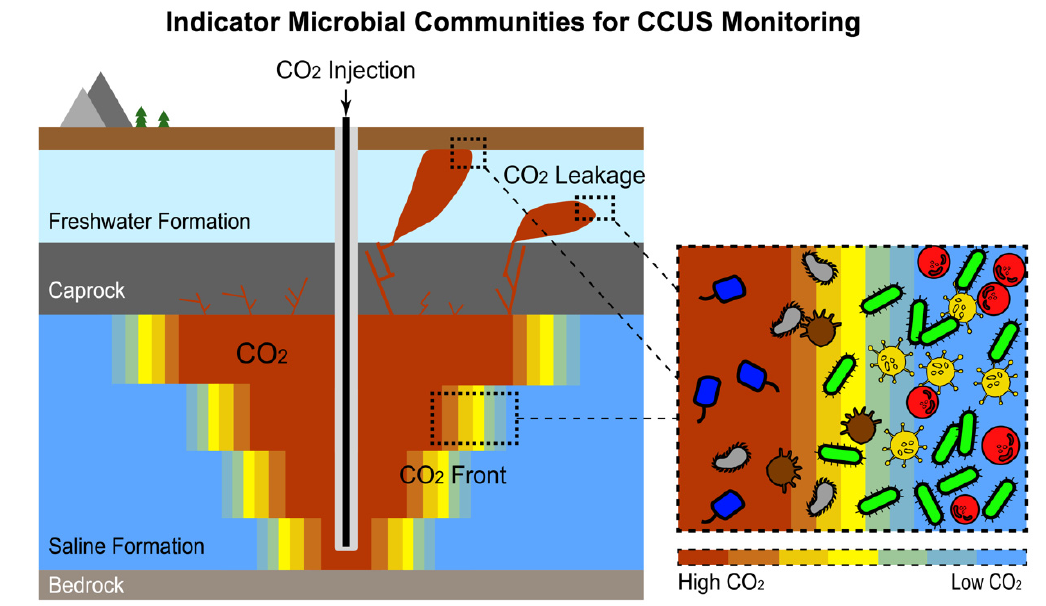
Figure 3. Schematic illustration of the use of indicator microbial communities as a naturally occurring DNA-based “tracer” for CO 2 front/leakage monitoring at carbon storage sites.